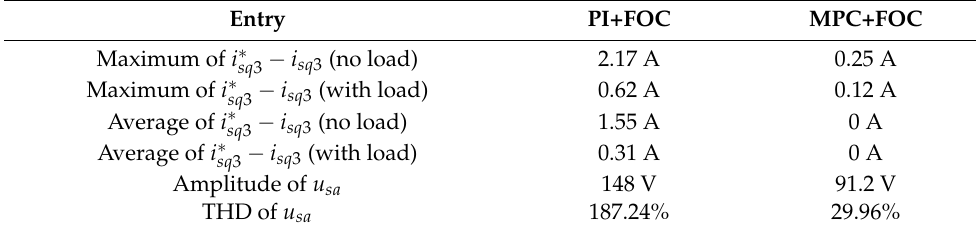
Table 2. Quantitative comparisons between the two control methods.